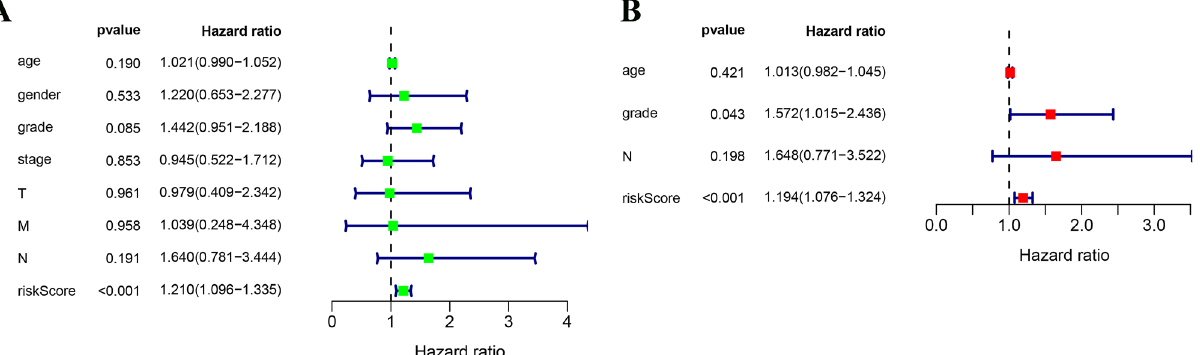
Figure 7. Independent prognostic analysis. ( A ) Forest plot of univariate; ( B ) multivariate.Cox regression analysis showed the risk score was an independent risk factor compared with other clinical features.